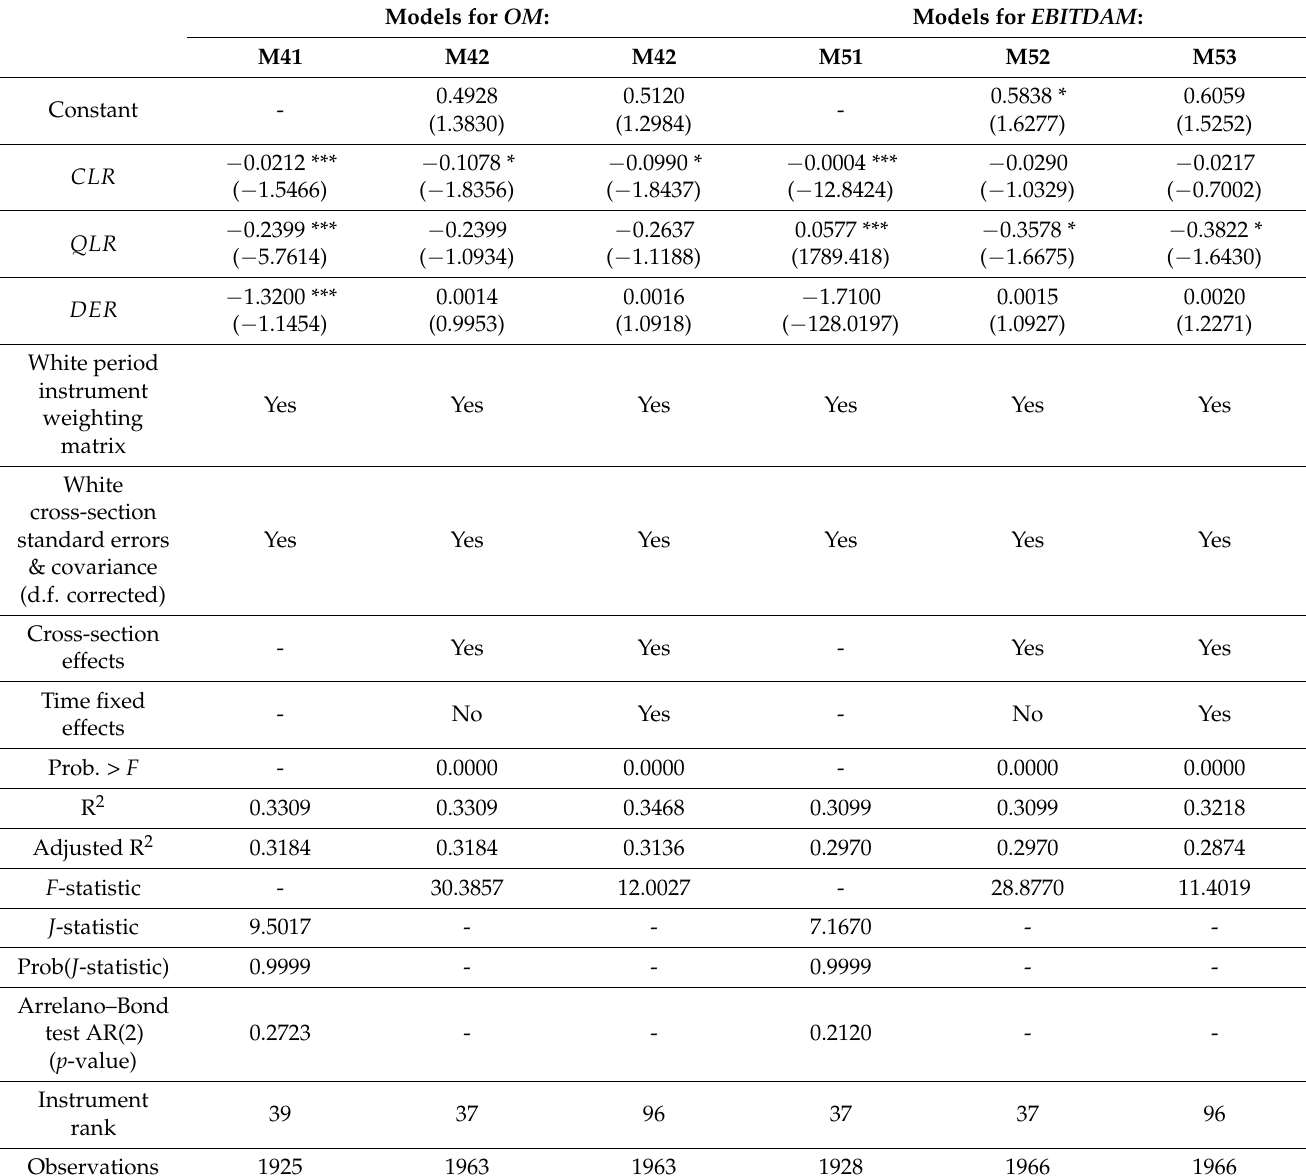
Table 4. Econometric models estimations corresponding to the dependent variables operating margin ratio ( OM ) and earnings before interest, tax, depreciation, and amortization ( EBITDAM